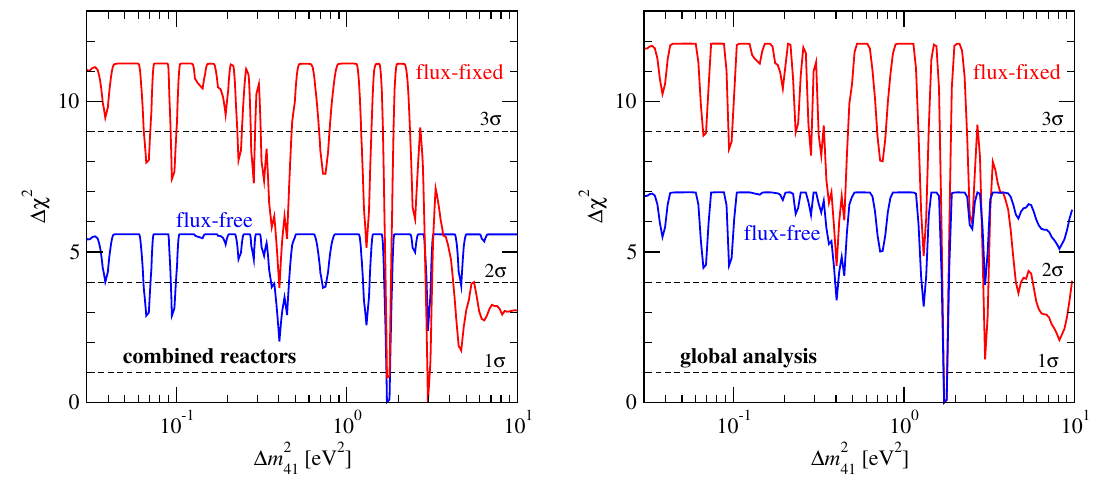
{ ) (cid:23) e disappearance data (right) minimized , for free (cid:13)uxes (blue curves) and (cid:12)xed (cid:13)uxes (red 41